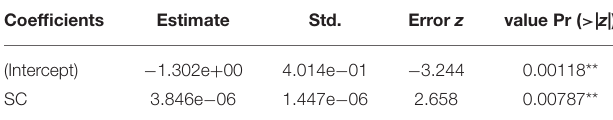
TABLE 3 | The estimation result of Probit